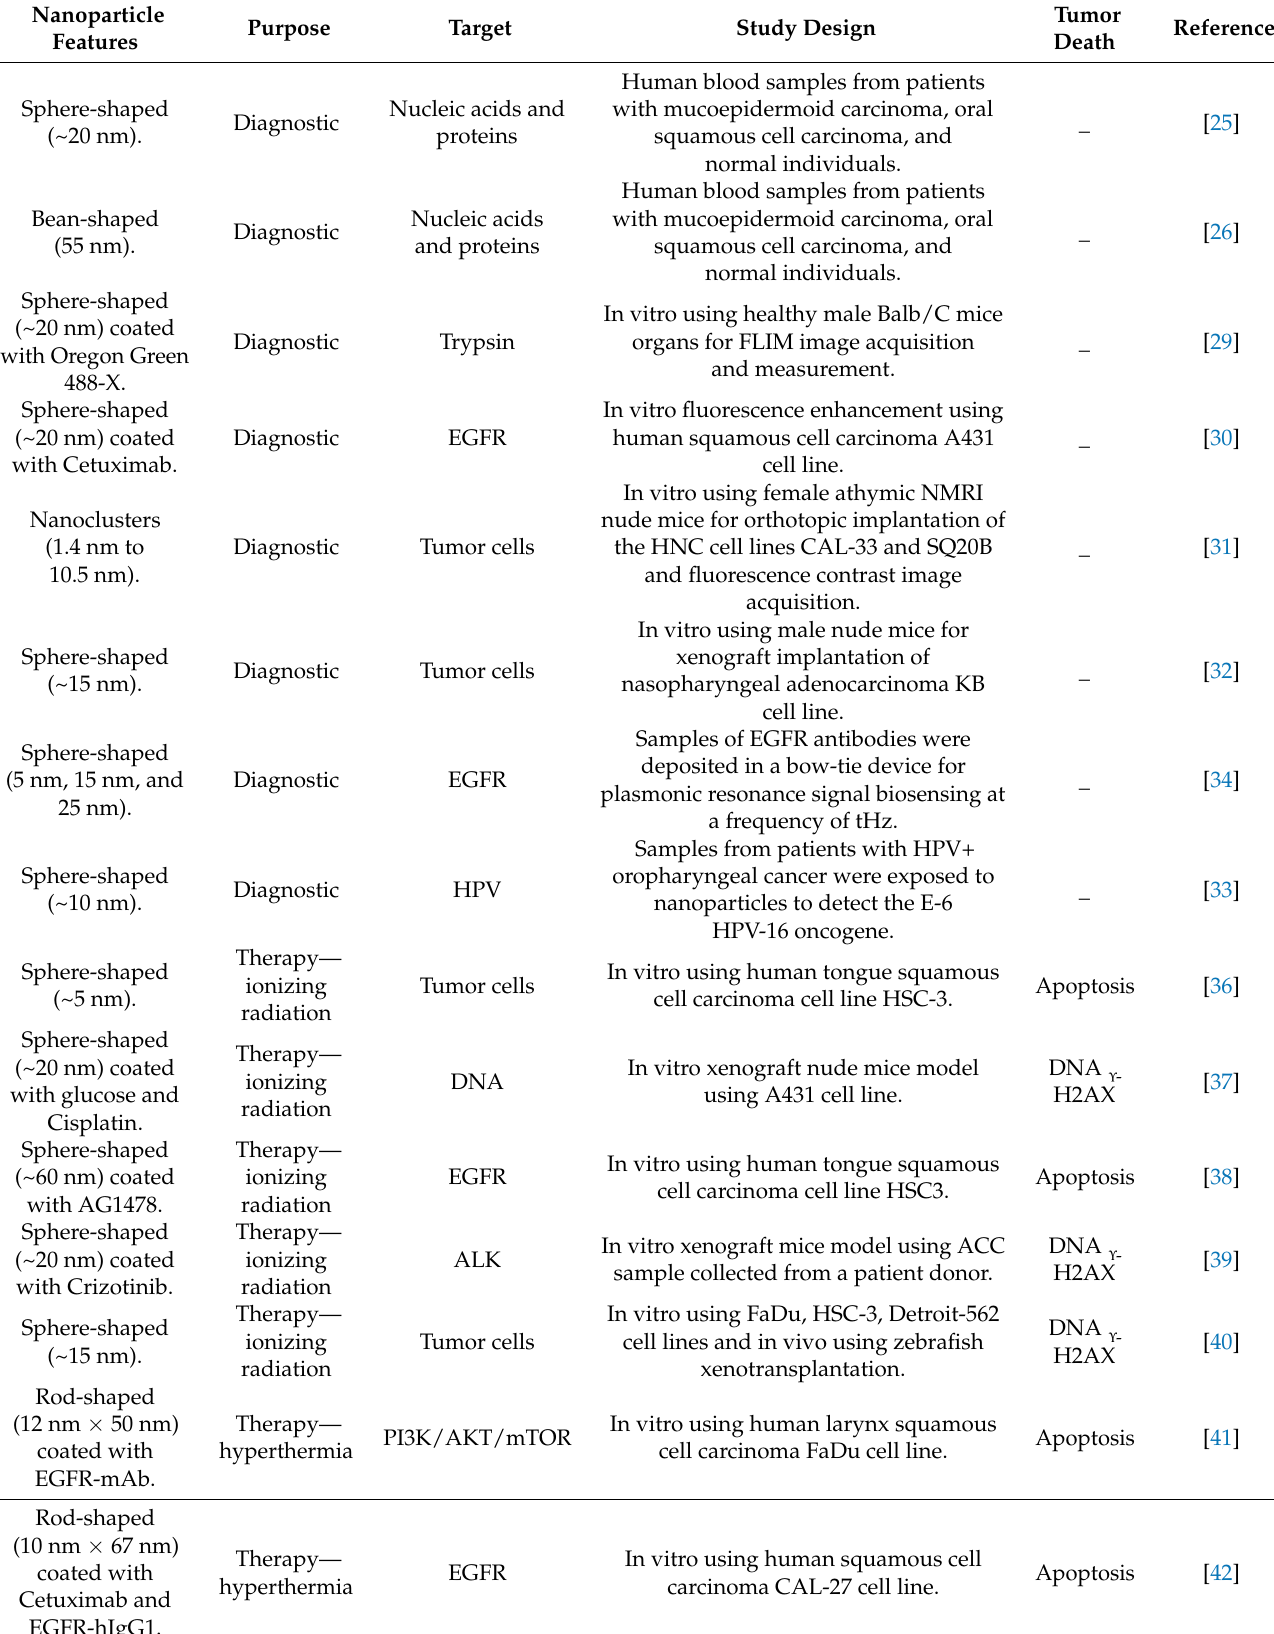
Table 1. AuNPs applied for HNC theranostic